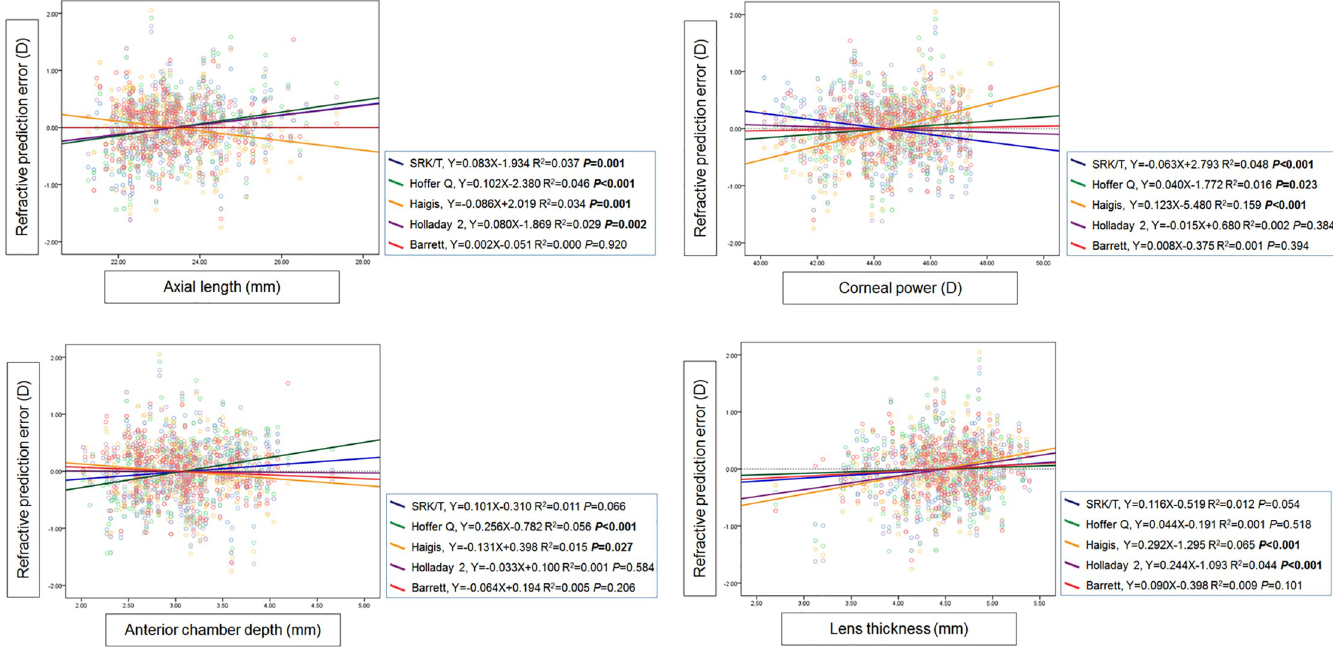
Fig 4. Scatterplots showing the correlations between the refractive prediction error calculated using the five formulas and ocular dimensions including axial length (AL), anterior chamber depth (ACD), mean keratometry, and lens thickness (LT).